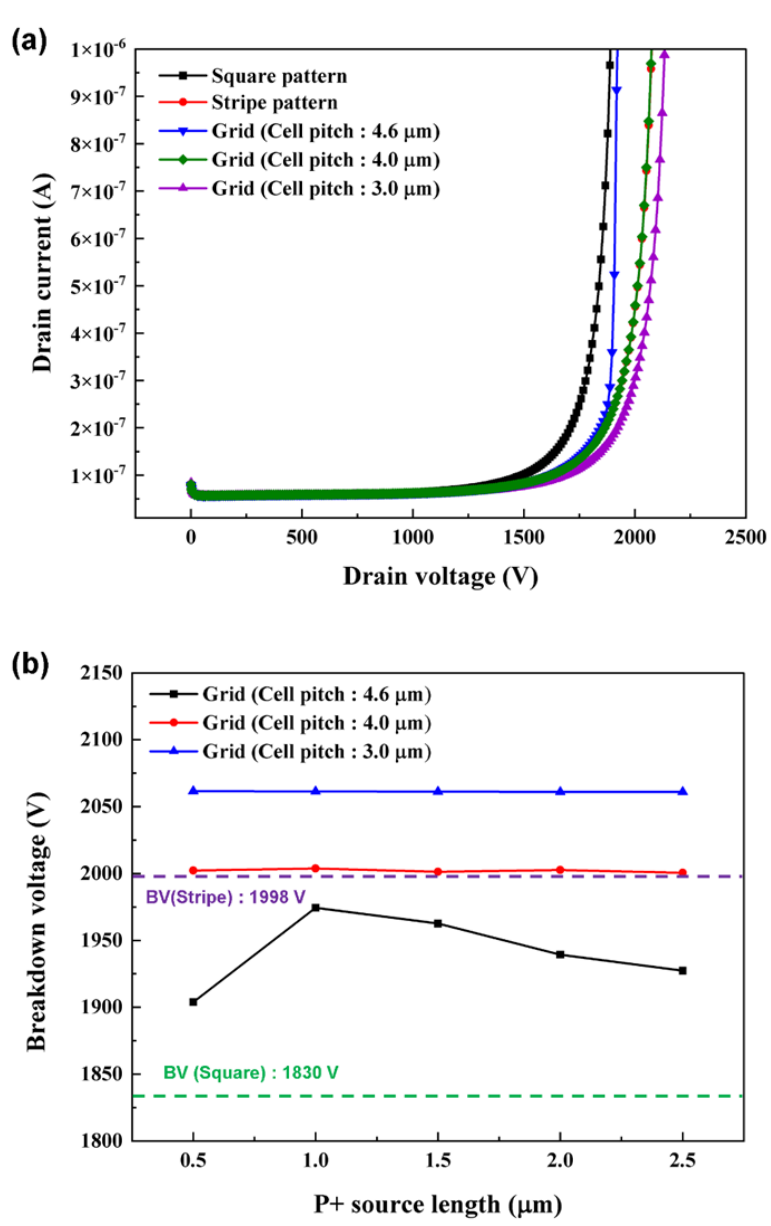
Figure 5. ( a ) Forward blocking behaviors of square, stripe, and grid patterns with cell pitches of 3.0 µ m, 4.0 µ m, and 4.6 µ m; ( b ) breakdown voltage of grid pattern with cell pitches of 3.0 µ m, 4.0 µ m, and 4.6 µ m, and L pp of 0.5~2.5 µ m.